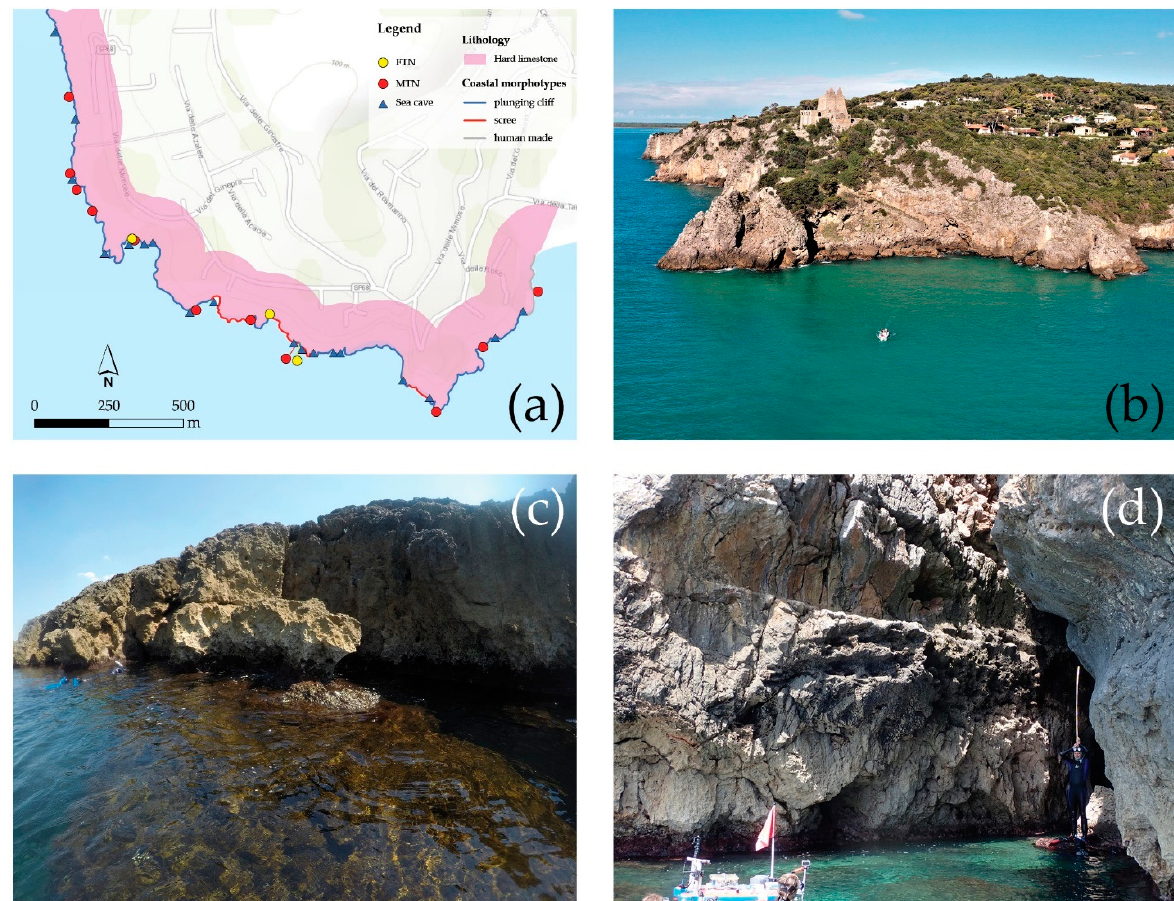
Figure 12 . ( a ) Maps of the surveyed geomorphological features at the Ansedonia Promontory; ( b ) plunging cliffs in the southernmost sector of the promontory; ( c ) MTN at a mushroom rock; ( d ) FTN at about 4 m ASL.